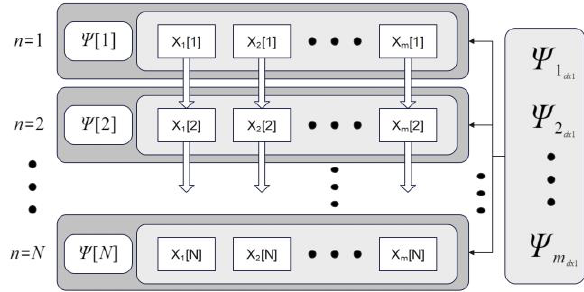
Figure 1. Graphic representation of NILM